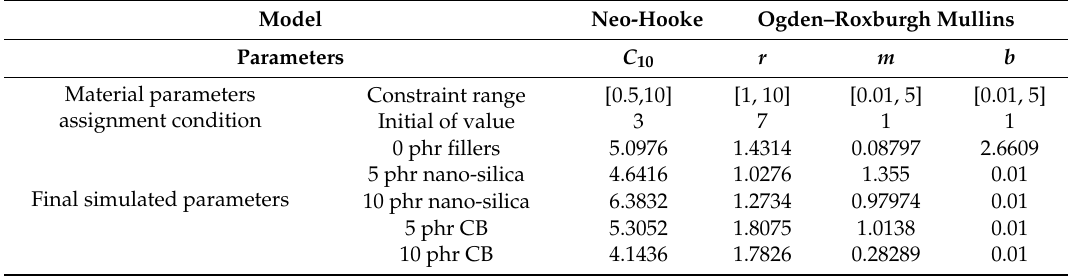
Table 1. Material parameters assignment conditions and final simulated